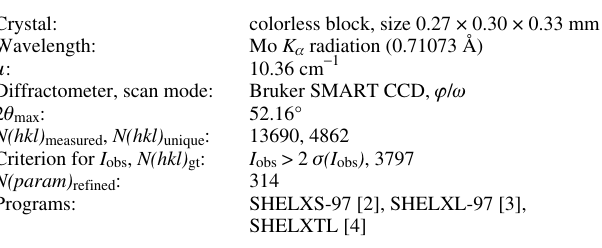
Table 1. Data collection and